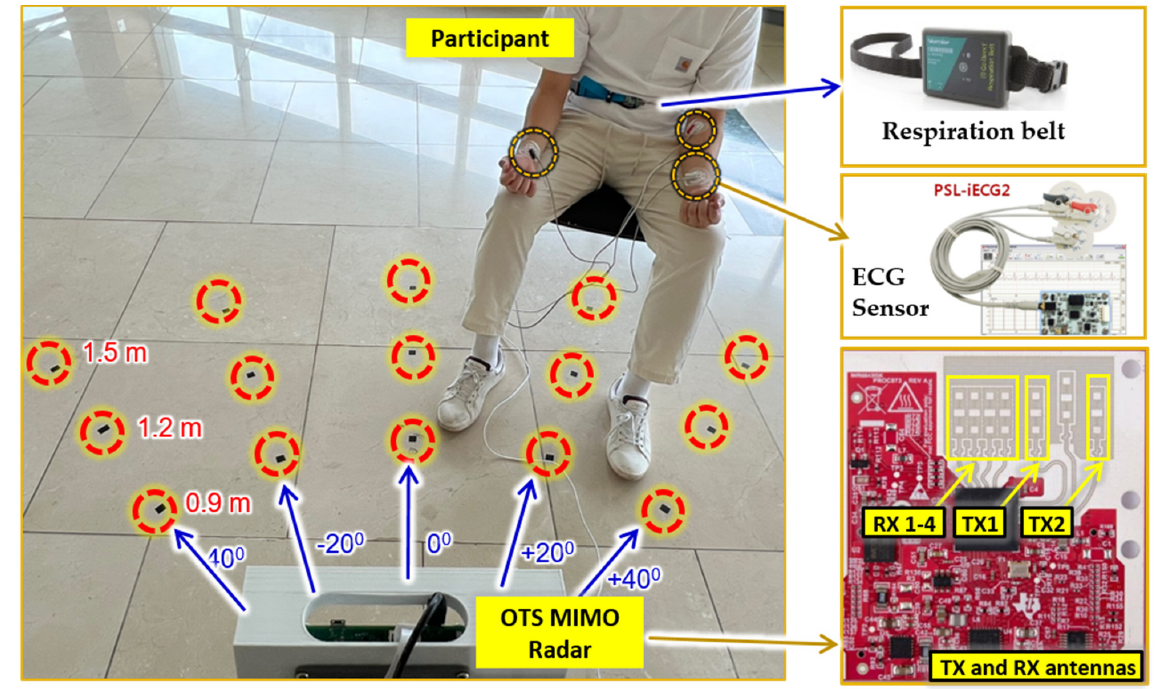
Figure 8. Actual experimental setup consisting of radar, ECG sensor, and respiration belt. The participant is sitting at a distance of 1.5 m from the radar with a horizontal axis of +20 degrees.